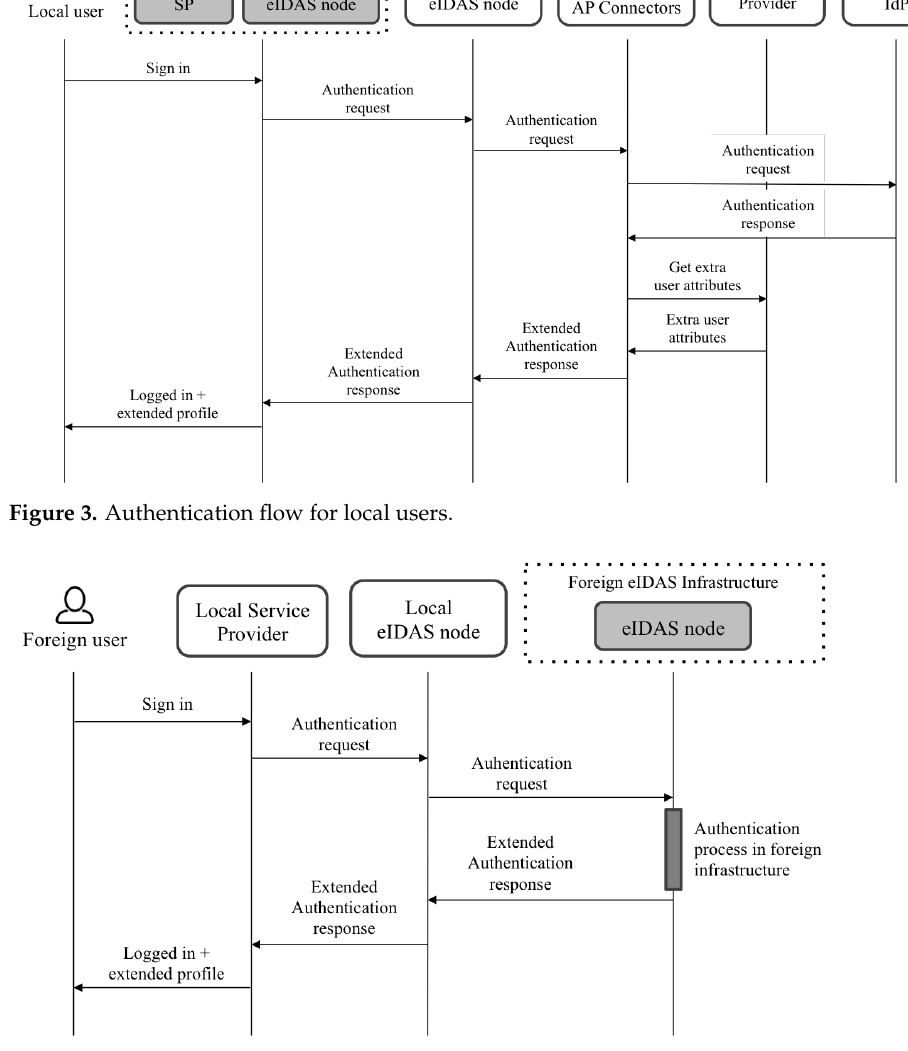
Figure 4. Authentication flow for foreign